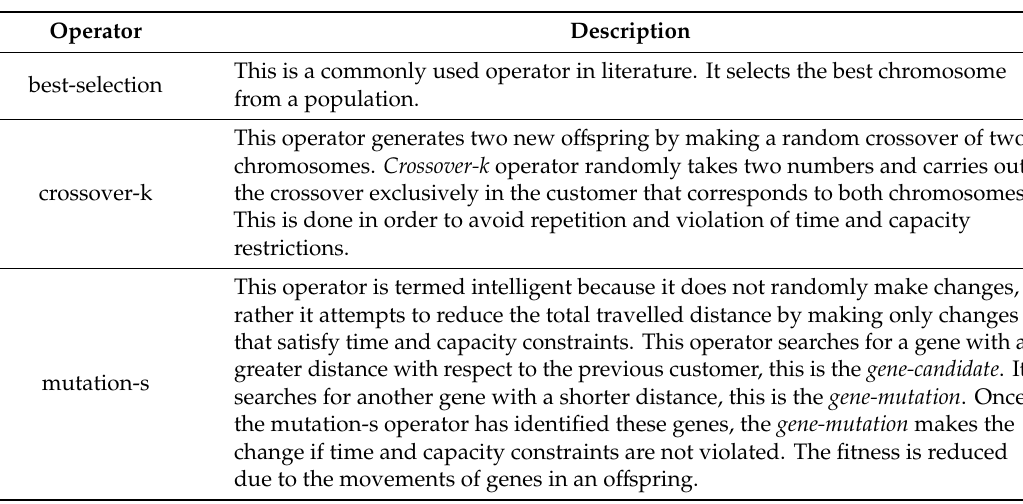
Table 1. Genetic operators in GA-VRPTW [1].